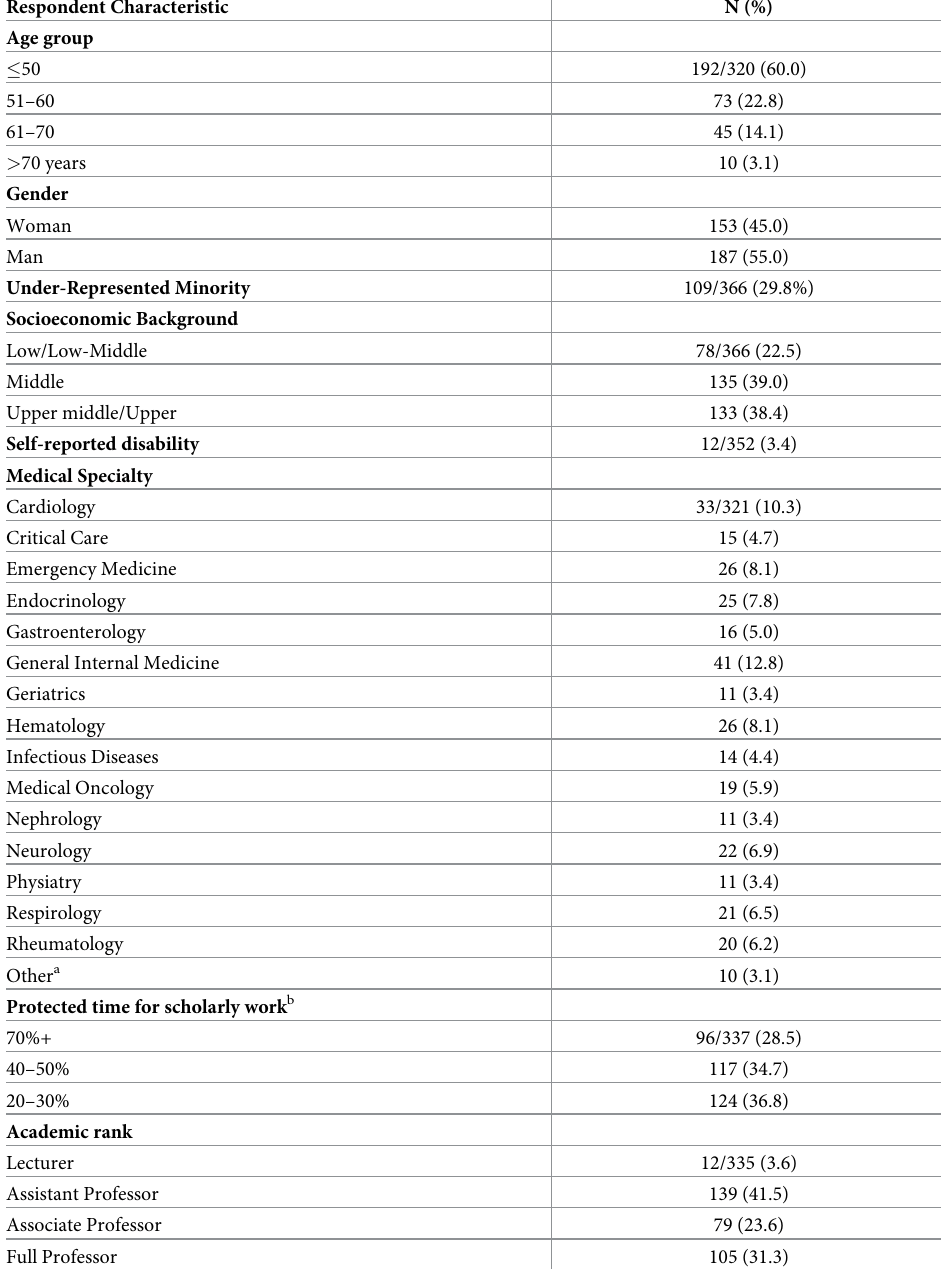
Table 1. Characteristics of physician respondents (n =